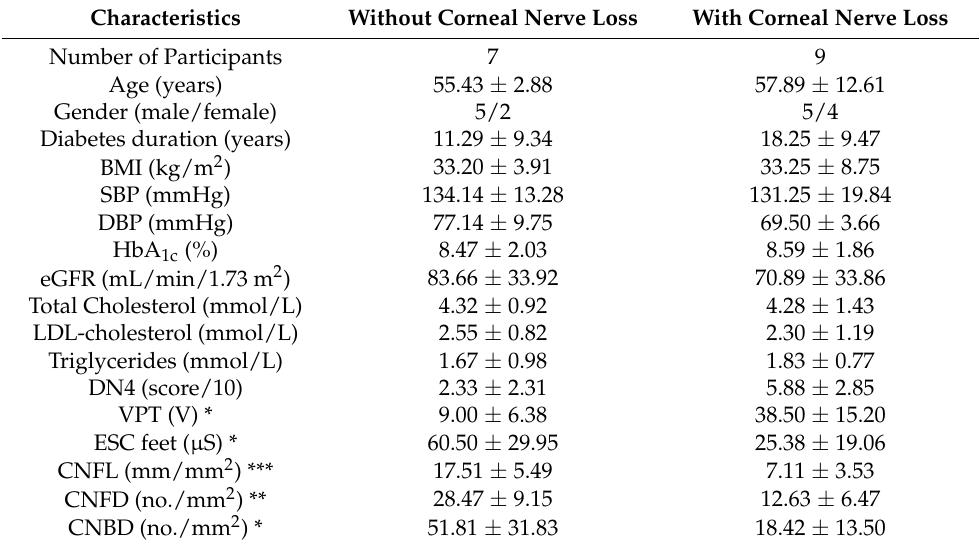
Table 1. Clinical, metabolic and neuropathy parameters in patients without and with corneal nerve loss. * p < 0.05, ** p = 0.001 *** p < 0.001.